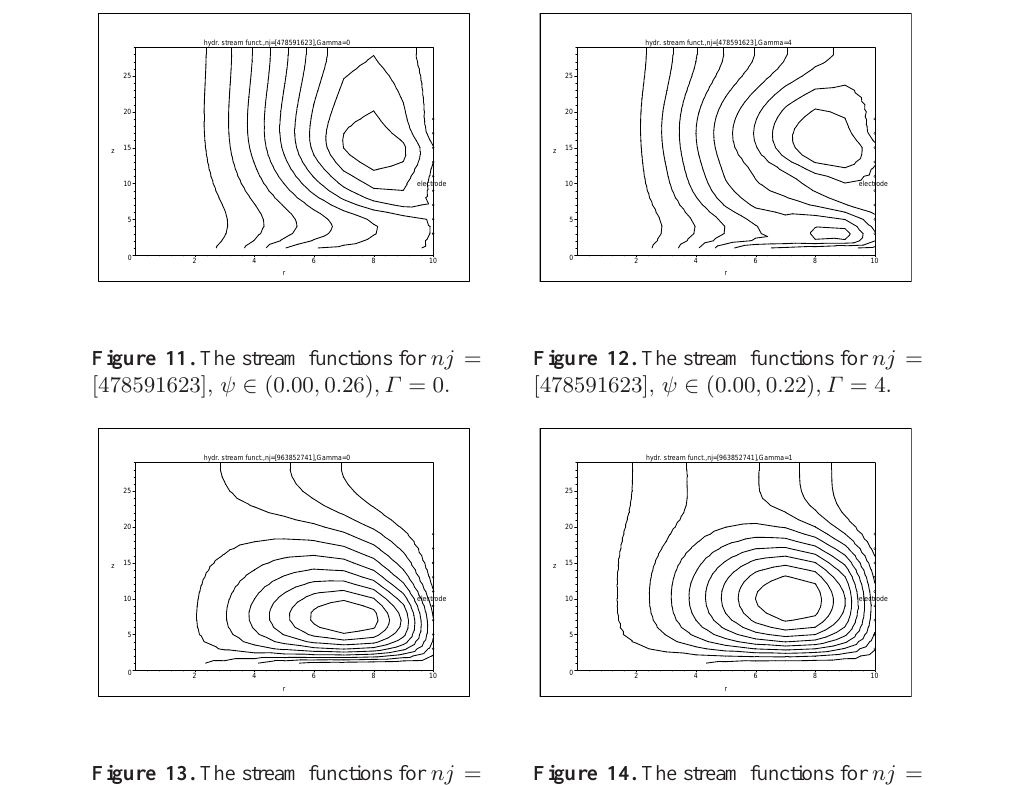
Figure 13. The stream functions for nj = [963852741] , ψ ∈ ( − 0 . 32 , 0 . 16) , Γ = 0 .